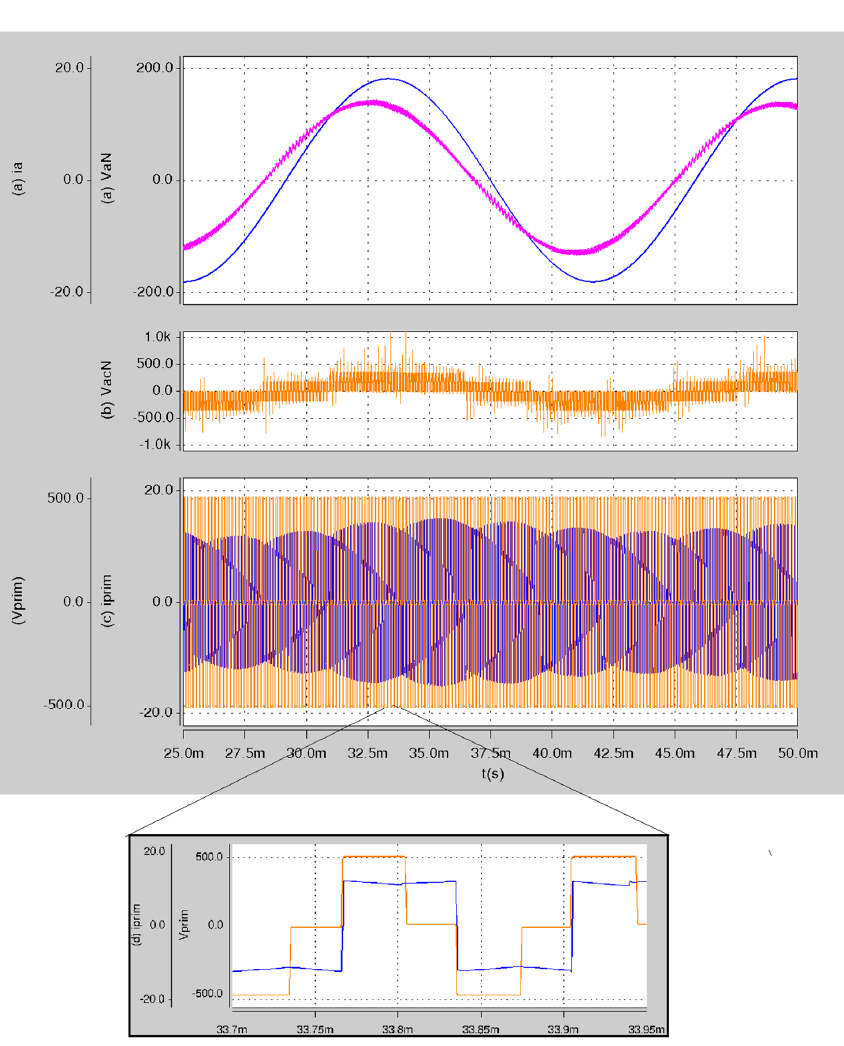
Figure 16. Simulation results ( a ) Supply voltage v aN and line current i a ; ( b ) converter voltage in phase a ; and ( c ) High-frequency current and voltage in the primary side of the transformer. Supply: 127 V, 60 Hz, Output: 100 V, 5 kW.